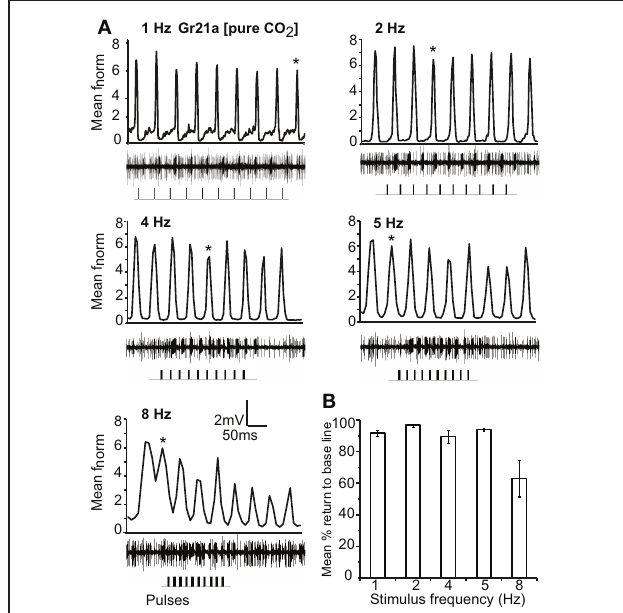
FIGURE 5 | Response of Gr21a-expressing OSNs to repeated stimulus pulses at varying frequencies. (A) Average normalized PSTH responses of Gr21a-expressing neurons to repeated pulses of pure CO 2 at listed frequencies. Traces below each panel show sample 50ms recordings. Square pulses indicate stimulus presentation. (B) Mean percent return to base line across all pulses of listed frequencies, error bars indicate SEM (ANOVA, P < 0 . 05, followed by Tukey post-hoc test, n =